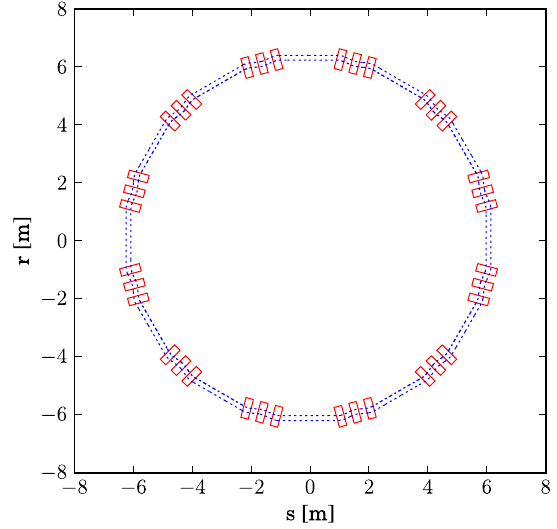
FIG. 2. Layout of the proton lattice with injection orbit (inner dotted line) and maximum energy orbit (outer dotted